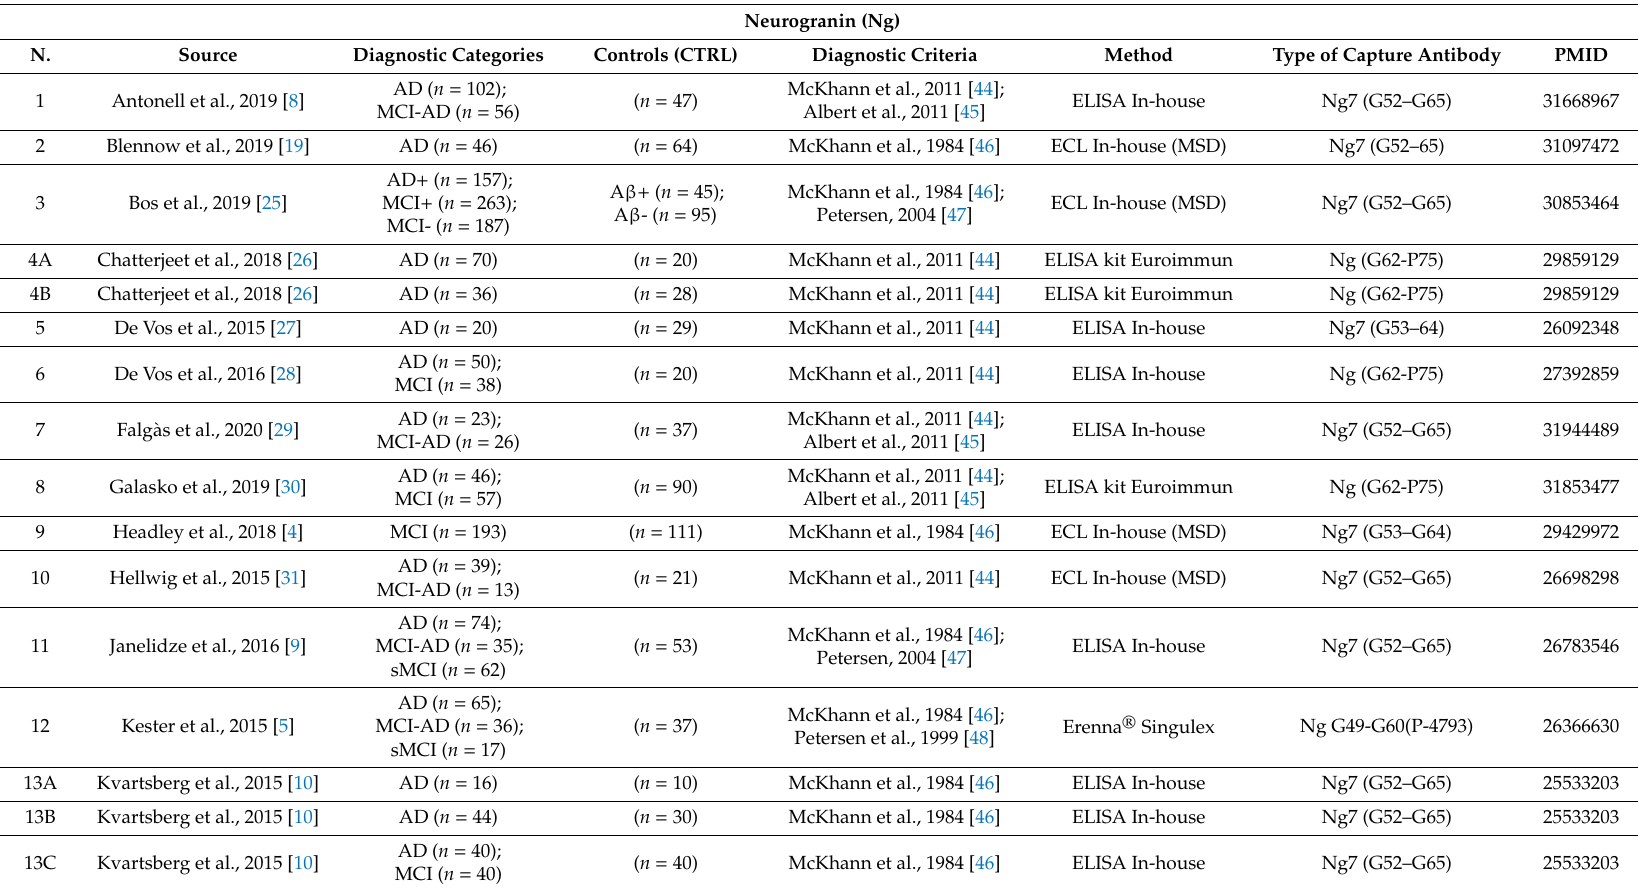
Table 1. Datasets included in the